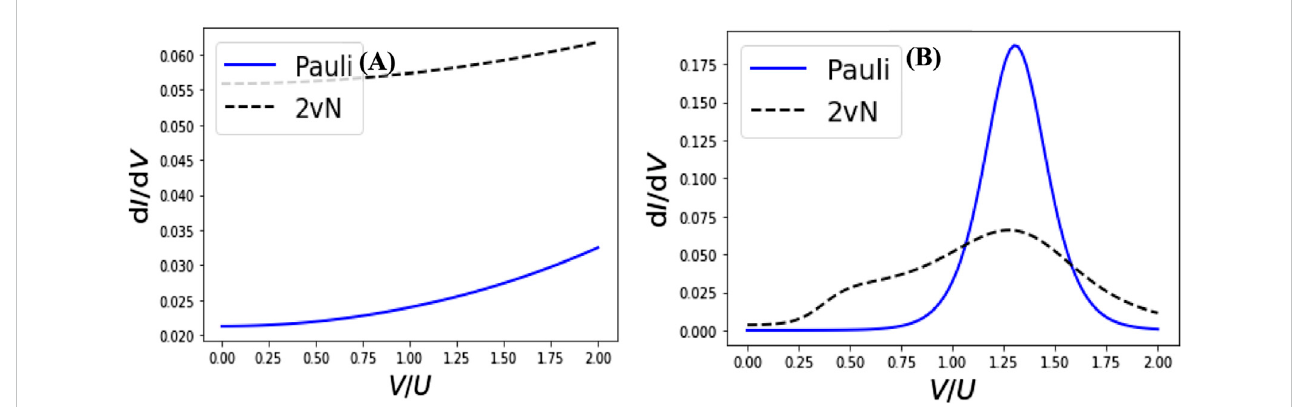
FIGURE 9 Bias trace at the particle – hole symmetric point at V gate = − U/2 for B = .375U in the SLC (A) and HRC (B) models of the embedded nanoline quantum dot